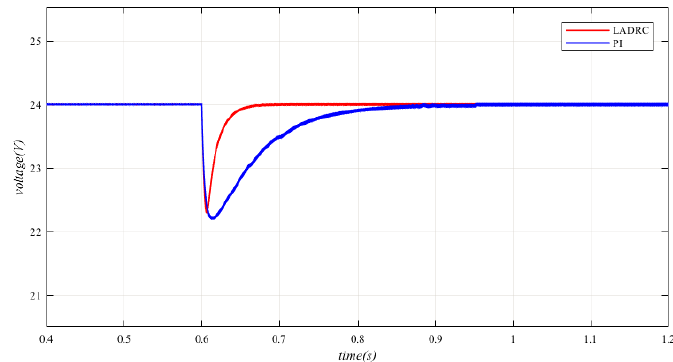
Figure 12. Output voltage responses in Case 3.